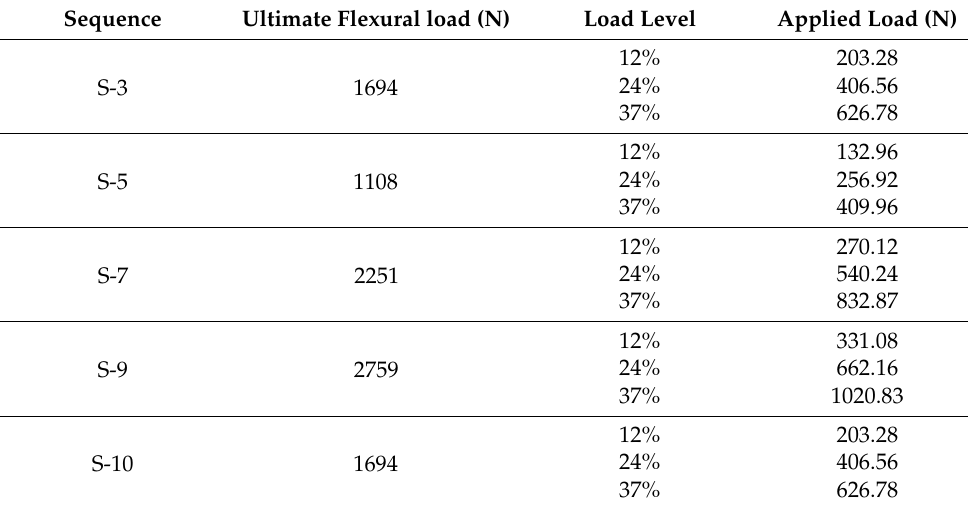
Table 4. Summary of the maximum flexural load and creep load